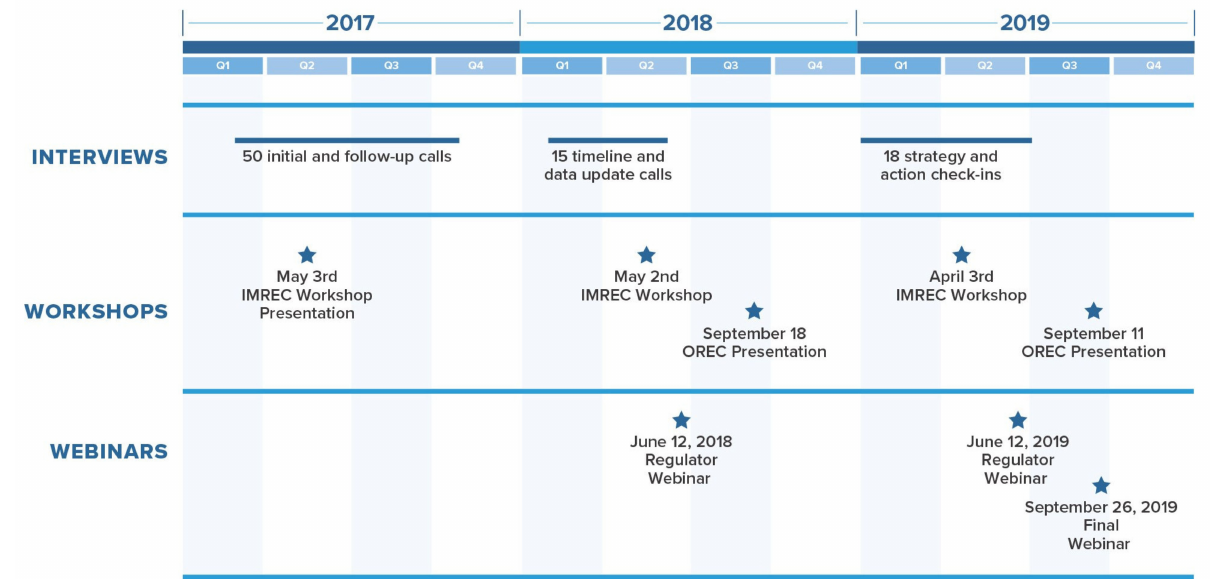
Figure 1. Outreach and Engagement Schedule Including Presentations and